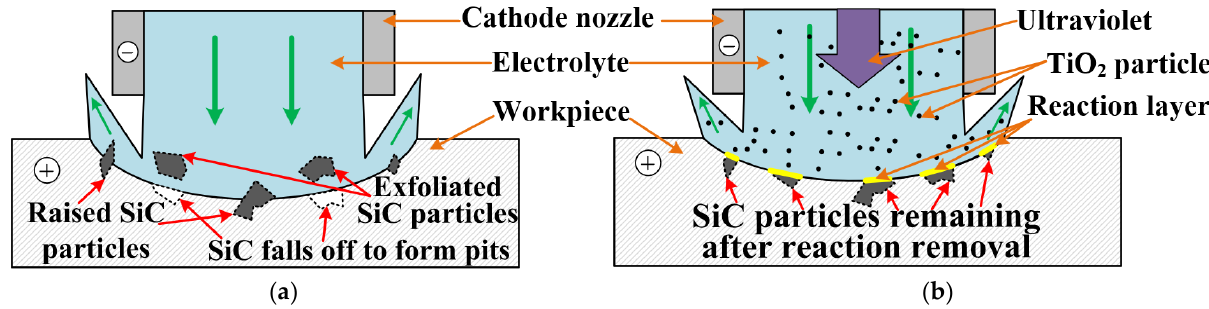
Figure 13. Schematic diagram of material removal mechanism in the ideal process: ( a ) JECM; ( b ) PAJECM.